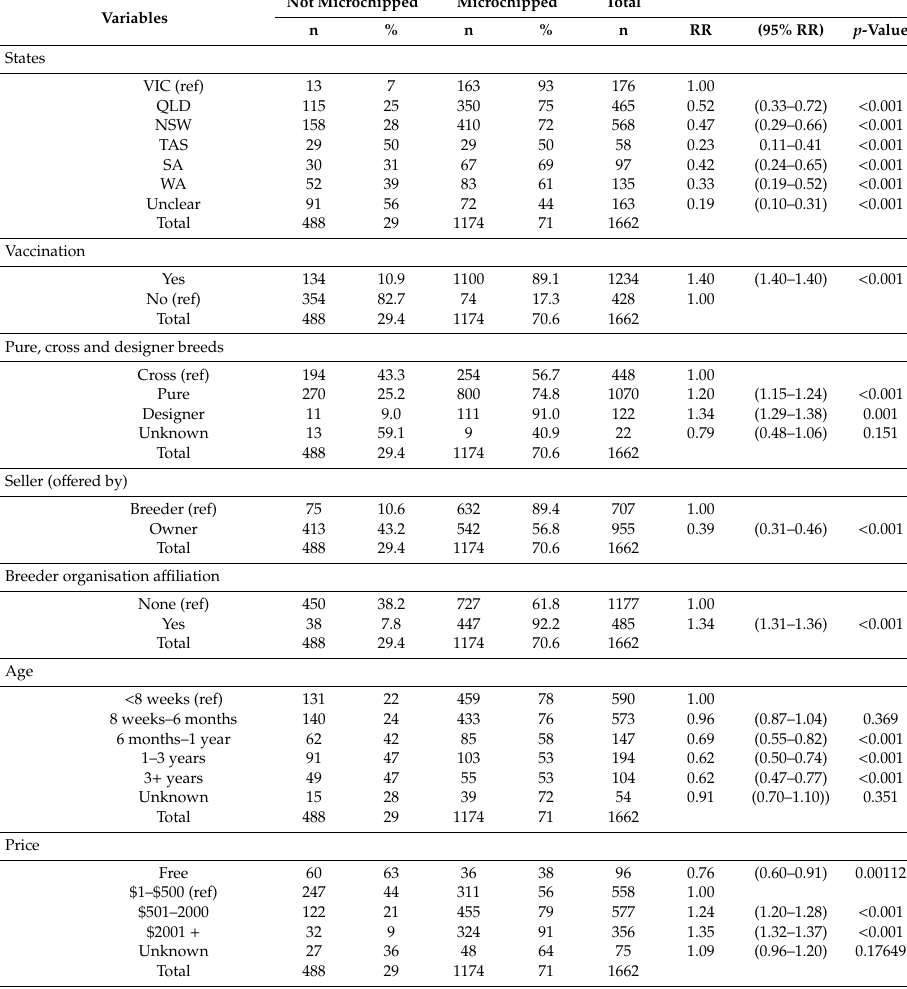
Table 4. Univariate analysis of factors associated with dogs being microchipped prior to sale from two individual webscrapes from Gumtree dog and puppy advertisements (25 March and 8 April 2019) in Australia. Australian Capital Territory and Northern Territory were excluded due to insu ffi cient counts, rescue and shelter advertisements were excluded due to interactions, leaving a total of 1662 unique advertisements for analysis. Predictors have been grouped for ease of interpretation with the reference indicated with a (ref) and a relative risk (RR) of 1. A p -value of < 0.05 was considered